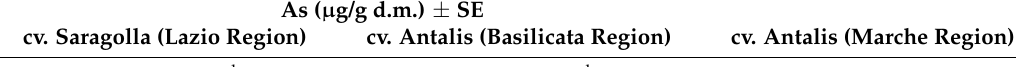
Table 4. Pasta: average values ± standard error (SE) of arsenic (As) content in semolina and selected air-classified fractions (F250, G250, and G230); d.m.: dry matter, different letters indicate significant difference ( p < 0.05 ), n =